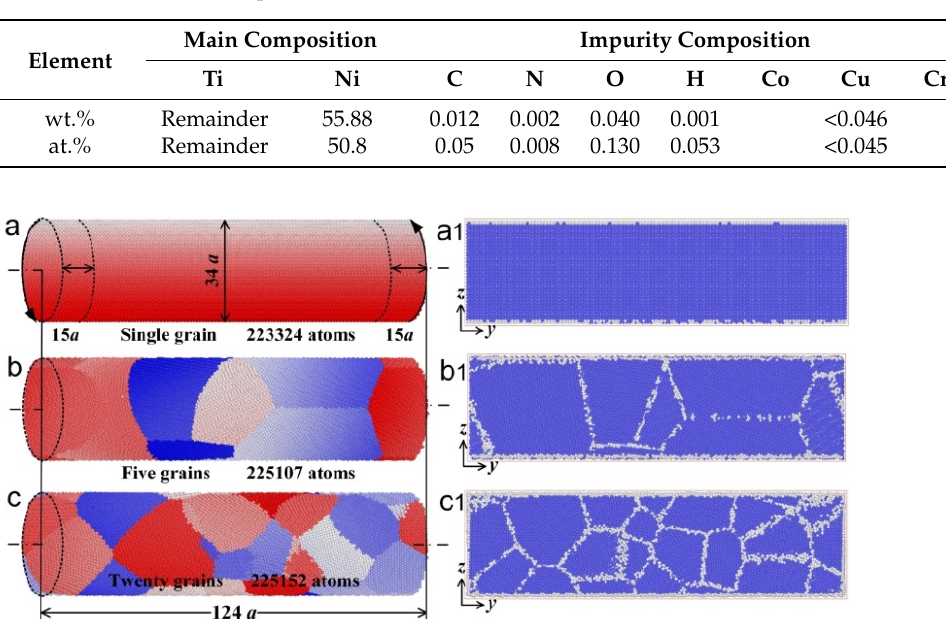
Table 1. The chemical compositions of the Ni 50.8 Ti wire.